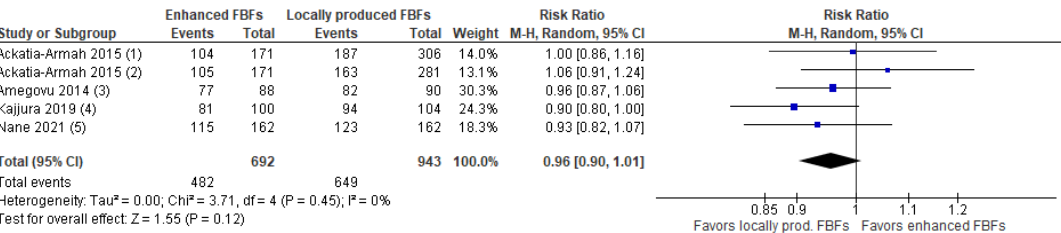
Figure 7. Forest plot of enhanced FBF compared to locally produced FBFs—Outcome: Recovery (1)